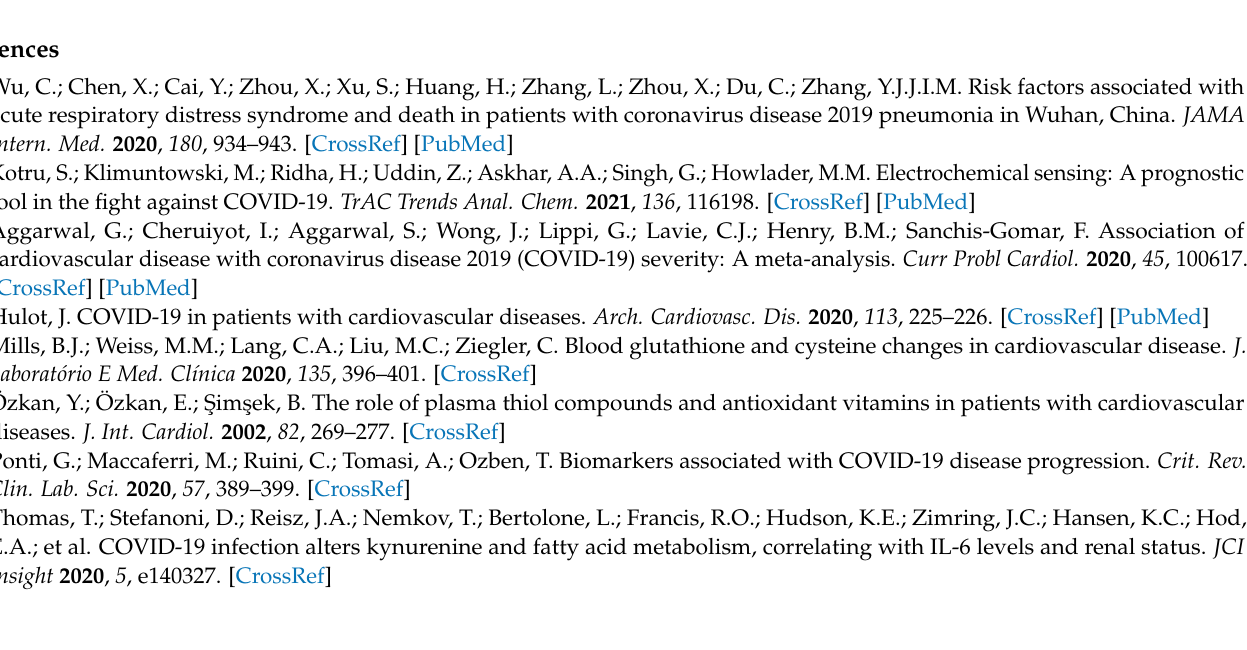
in 3D printing for clinical analysis; Figure S2: (A) Flexible platinum electrodes fabricated by pho- tolithography on Bio-PET substrate (geometric area of 0.03 ± 0.1 cm 2 ); (B) Mechanical stress process applied to an electrode; Figure S3: EDS spectra for the semi-quantitative distribution of chemical elements on the platinum electrode surface; Figure S4: SEM images of Pt film thickness; Figure S5: (A) Cyclic voltammograms of the flexible platinum electrode in the presence ( — ) and absence ( — ) of an equimolar mixture of 5.0 mmol L − 1 [Fe(CN)6] 3 − /4 − ; (B) Cyclic voltammograms obtained varying the scan rate at 10, 20, 30, 50, 70, 90, 110, 130, 160, 200 and 250 mV s − 1 ; Inset: plot of current response in function of v 1/2 ; Figure S6: Proposed mechanism of the oxidation of L-Cys on the surface of the Pt electrode; Figure S7: Effect of pH for the cyclic voltammetric behavior of the Pl electrode in presence of 500 µ mol L − 1 L-Cys; Figure S8: (A) Cyclic voltammograms obtained with the Pt electrode in 0.1 mol L − 1 PBS (pH 6.0) containing 1000 µ mol L − 1 L-cysteine at different scan rates, from 0.01 to 0.30 V s − 1 . (B) Linear plot of L-cysteine Ipa versus v 1/2 (V s − 1 ) 1/2 ; Figure S9: (A) Chronoamperogram and (B) current response obtained for successive additions of L-Cys and different interfering species; Figure S10: Fit simulation of the equivalent circuit for the first and last immunosensor modification step; Figure S11: Square wave voltammetry direct (A–C) and reverse (A (cid:48) –C (cid:48) ) effect of experimental conditions as function of peak width at half height (A”–C”); Table S1: Analytical performance of the Pt-based sensor for the L-Cys determination compared with other sensors in the